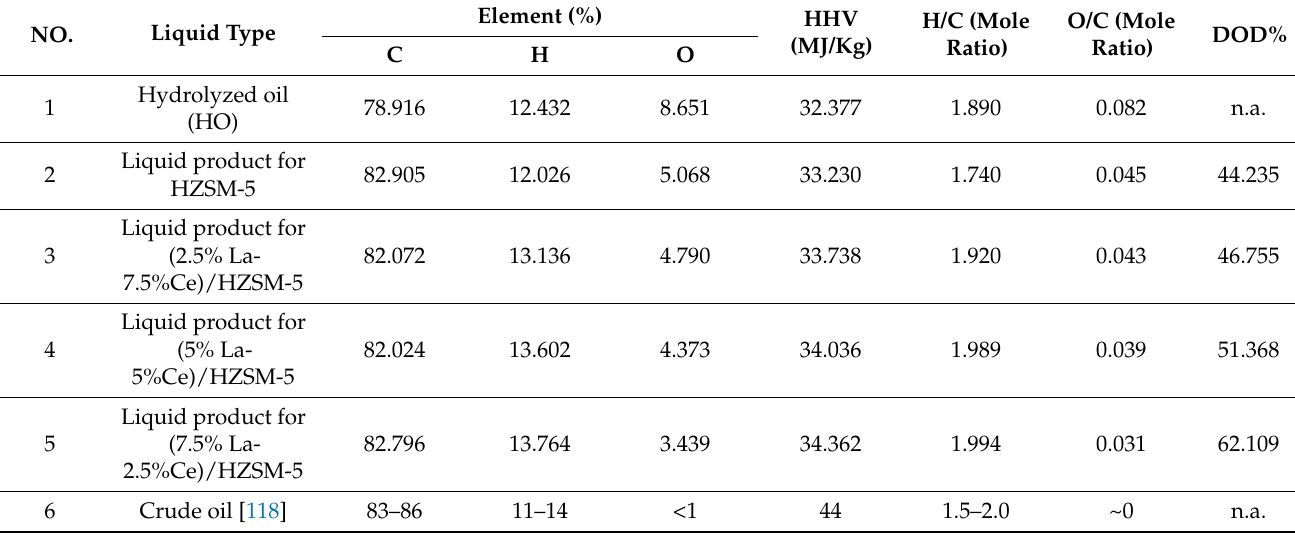
Table 8. The degree of deoxygenation, elemental composition, higher heating value, H/C and O/C atomic ratios and the algal HO, and the liquid products of the catalytic deoxygenation for the parent HZSM-5 and Lanthanum-Cerium-modified zeolite